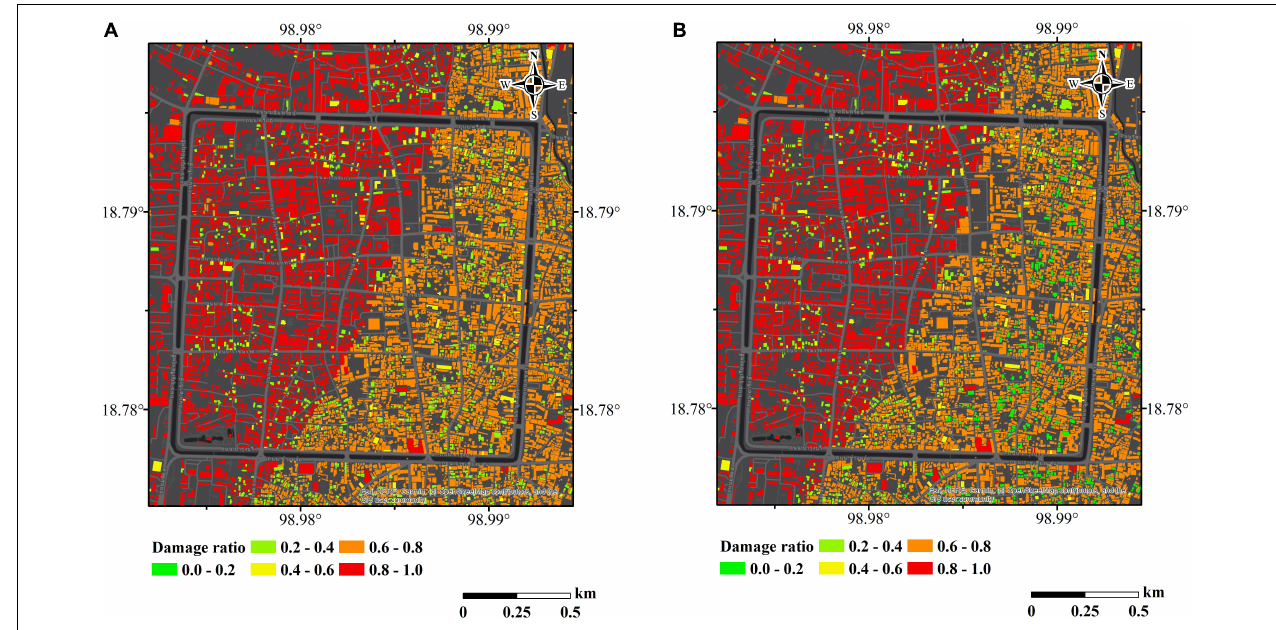
FIGURE 9 | Comparison of building damages between CSM and ANFIS in Chiang Mai old town. (A) by CSM (B) by the proposed ANFIS model.